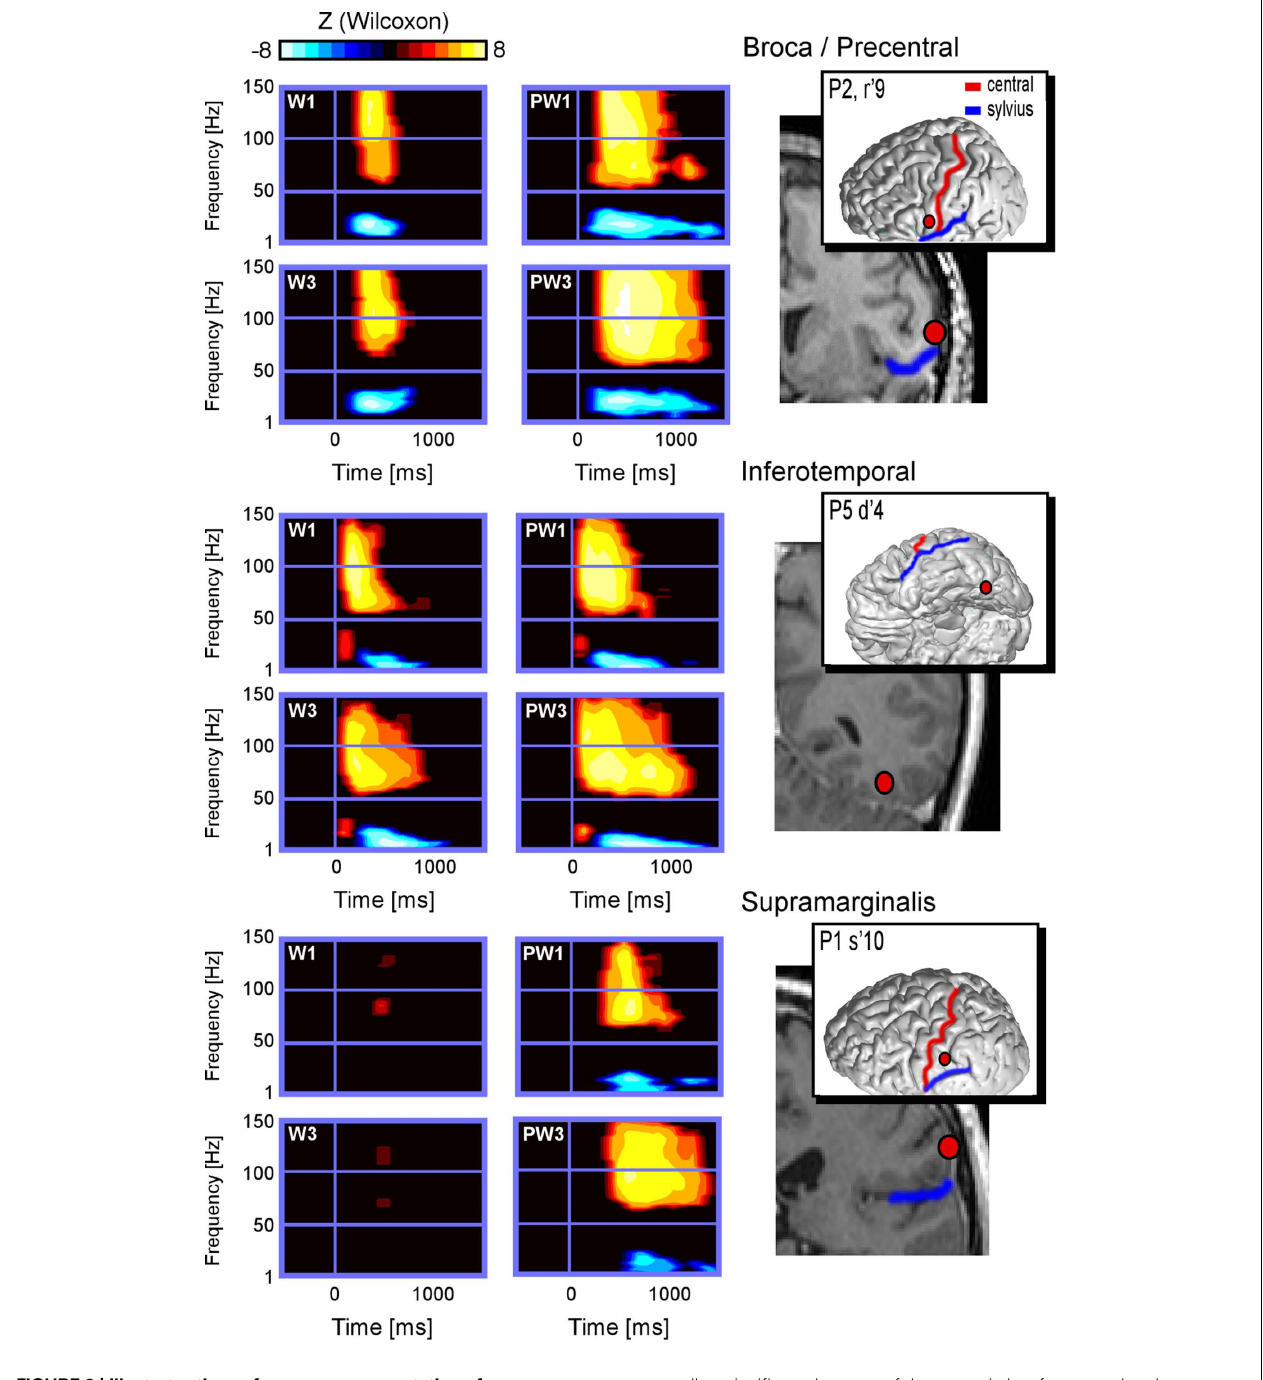
FIGURE 2 | Illustrates time × frequency representation of spectral responses in the regions of interest induced by short and long words and pseudo-words in patients 1, 2, and 5. Compared to baseline (Wilcoxon Z threshold at p < 0.05), all regions showed significant increase of the power in high gamma-band frequency,